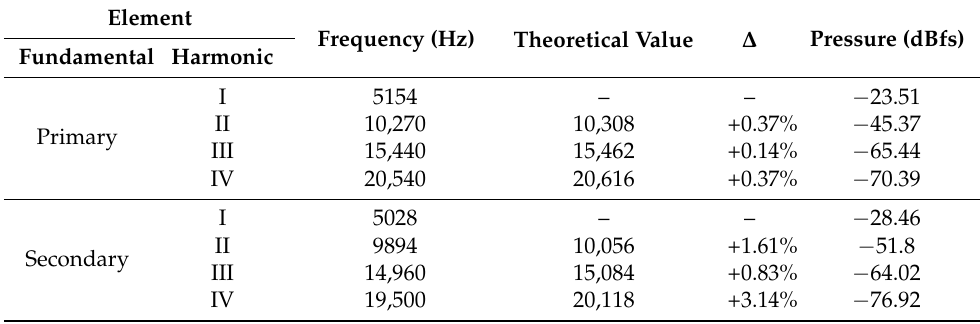
Table 4. Harmonic structure of the July calling/advertising song of Acheta pantescus n. sp. in the high-quality stereo recordings, based on a sample size of 10 s.